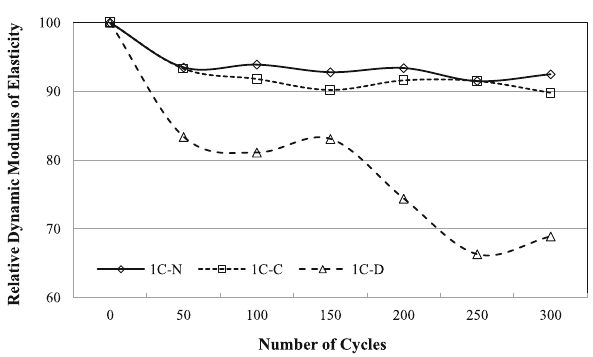
Fig. 8 Effect of mix proportioning method on the drying shrinkage for mix series 2. Fig. 9 Effect of aggregate sources on the freeze–thaw resistance for mix series